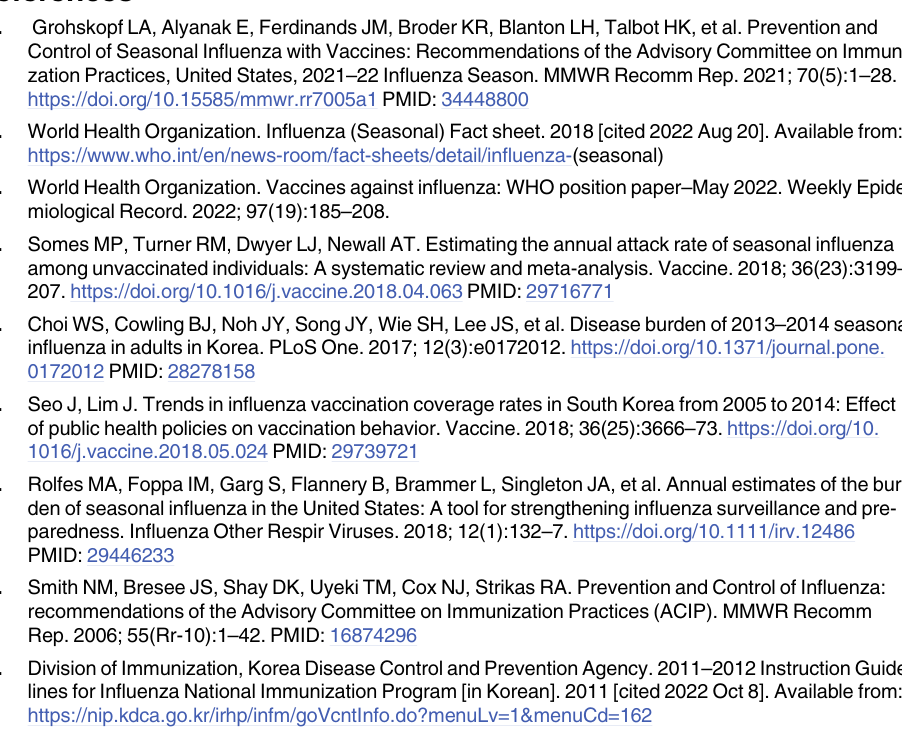
S2 Table. Number of COVID-19 cases per 100,000 people by each region. S3 Table. Influenza vaccination coverages of OECD member countries for population